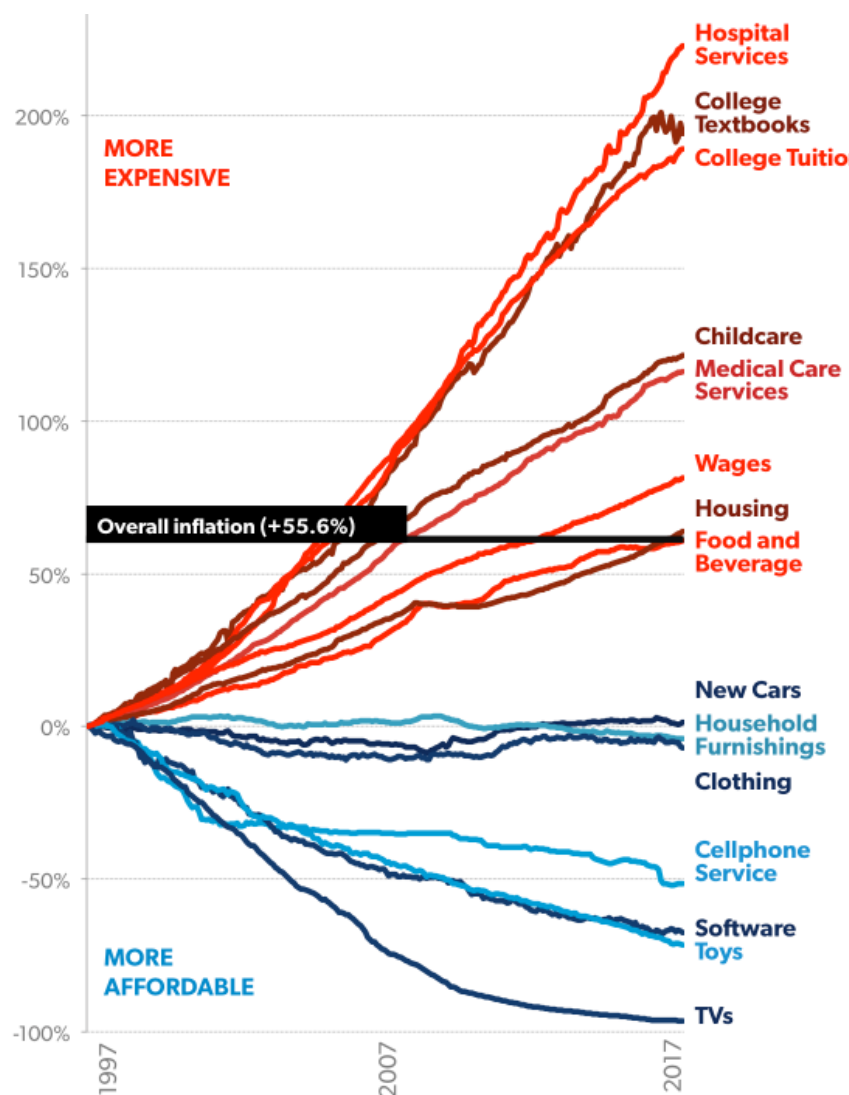
Fig. 13 . Changes since January 1997 in the prices of selected consumer goods and